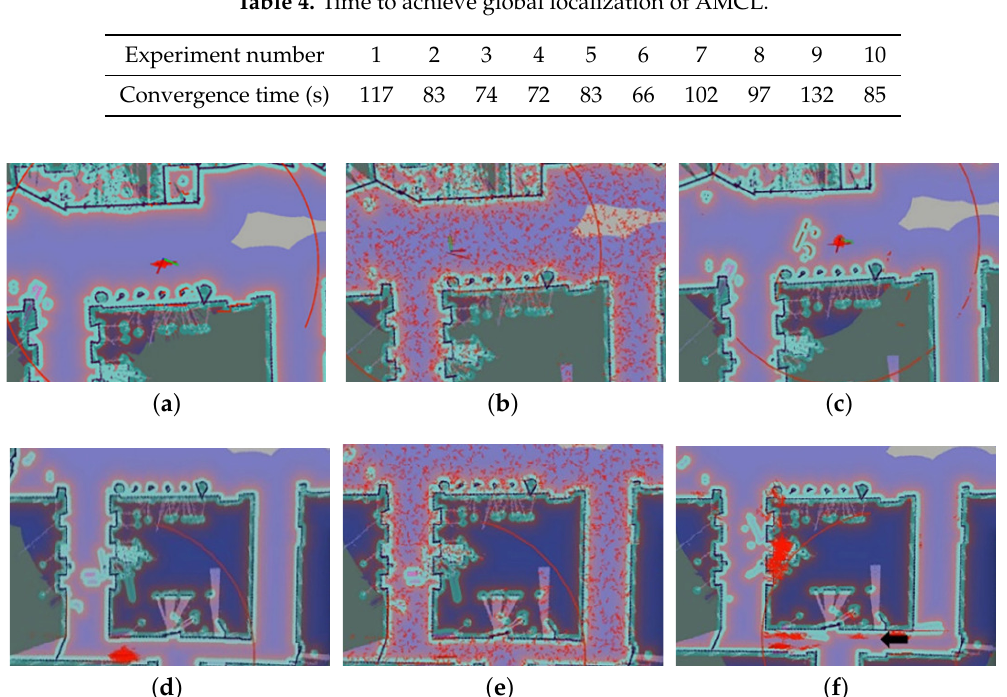
Figure 11. Comparison of global localization between AMCL and UAPF. ( a ) The initial pose of UAPF. ( b ) Global localization with UAPF. ( c ) Result of global localization using UAPF. ( d ) The initial pose of AMCL. ( e ) Global localization with AMCL. ( f ) Result of global localization using